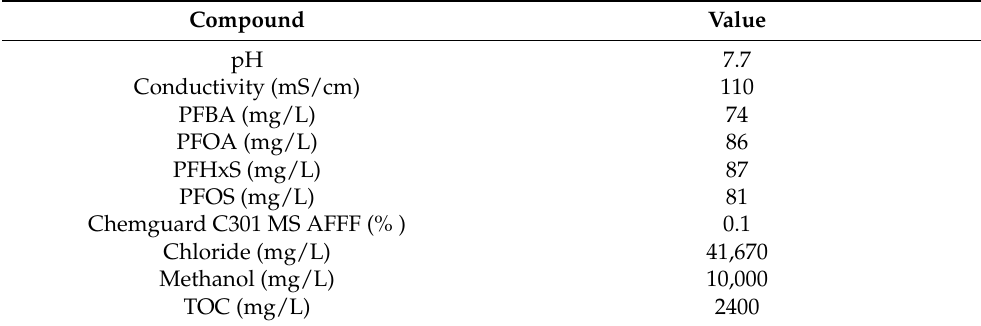
Table A1. Characterization of the synthetic still bottoms solution used for the electrochemical treatment of PFAAs in both the laboratory and semi-pilot scales.